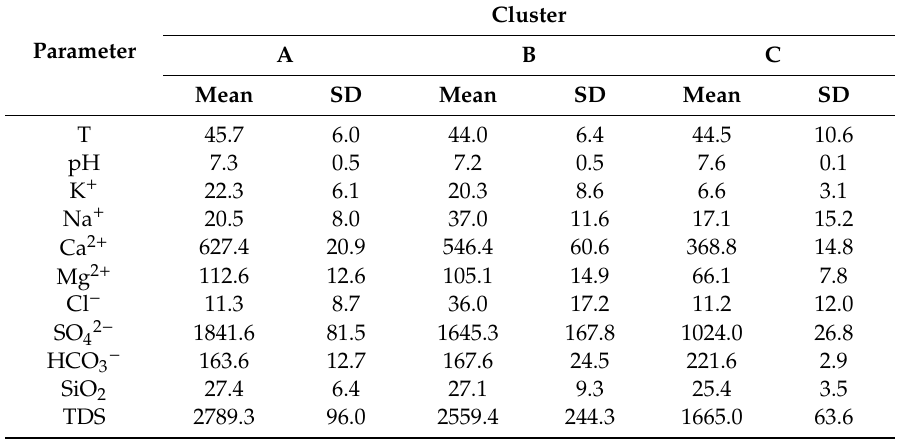
Table 1. Average and standard deviation of hydrochemical parameters for three clusters water samples (in mg/L except T and pH).